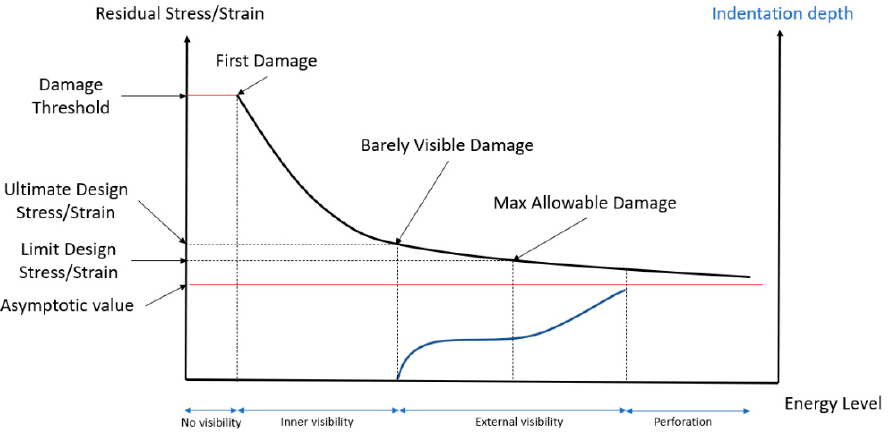
Figure 32. Schematic representation of residual strain versus energy level and derived design constraints.